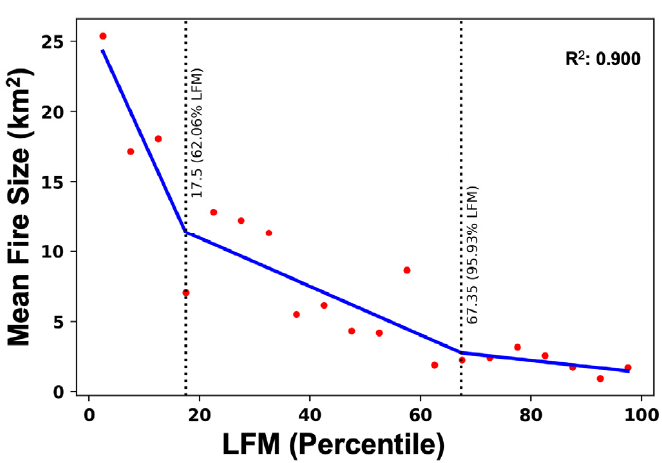
Figure 5. LFM of predicted LFM percentiles vs. mean fire size. Mean fire size was calculated as the mean area burned among all fires within each successive 5 percentiles of LFM. Dashed lines indicate calculated breakpoints between LFM domains (measured both as LFM percentile rank and actual LFM).